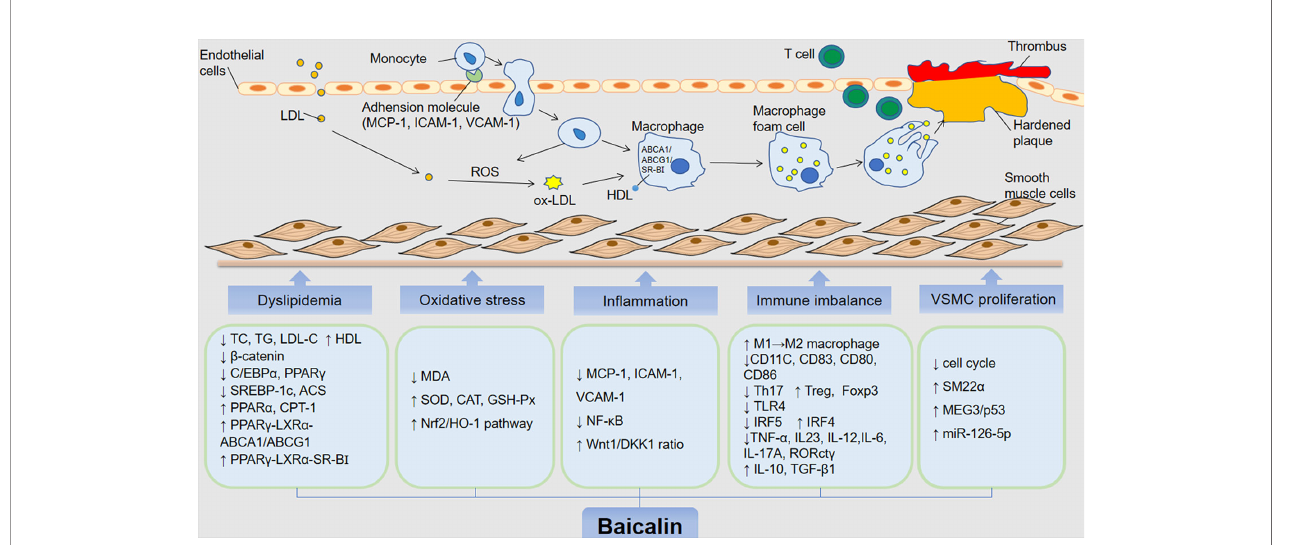
FIGURE 3 | The anti-atherosclerotic effects by which baicalin alleviates the development of AS. The role of baicalin in inhibiting atherosclerosis includes hypolipidemic effects and inhibition offoam cell formation, inhibition of oxidative stress, mitigation of in fl ammatory response, immunomodulatory, suppression of VSMC proliferation and migration. low density lipoprotein (LDL); oxidized LDL (oxLDL); oxygen reactive species (ROS); high-density lipoprotein (HDL); total cholestero (TC); triacylglycerol (TG); low-density lipoprotein cholesterol (LDL-C); CCAAT/enhancer bindingproteins a (C/EBP a ); peroxisome proliferator-activated receptor g (PPAR g ); liver receptor X (LXR a ); ATP binding cassette (ABC) transporter A1/G1 (ABCA1/G1); scavenger receptor BI (SR-BI); sterol regulatory element-binding protein 1c (SREBP-1c); Acyl-CoA synthase (ACS); peroxisome proliferator-activated receptor a (PPAR a ); carnitine palmitoyltransferase 1 (CPT-1); malondialdehyde (MDA); superoxide dismutase (SOD); catalase (CAT); glutathione peroxidase (GSH-Px); nuclear factor E2-associated factor 2 (Nrf2); heme oxygenase-1 (HO-1); monocyte chemoattractant protein 1 (MCP-1); intercellular adhesion molecule 1 (ICAM-1); vascular adhesion molecule 1 (VCAM-1); nuclear factor kappa B (NF- k B); dickkopf-related protein-1 (DKK 1); interleukin 10/12/23/6/17A (IL-10); interferon regulatory factor 4 and 5 (IRF4/5); tumor necrosis factor (TNF)- a ; transforming growth factor- b 1 (TGF- b 1); toll-like receptor (TLR4); smooth muscle (SM) 22 a ; factor forkhead box protein P3 (Foxp3); maternally expressed gene 3/p53